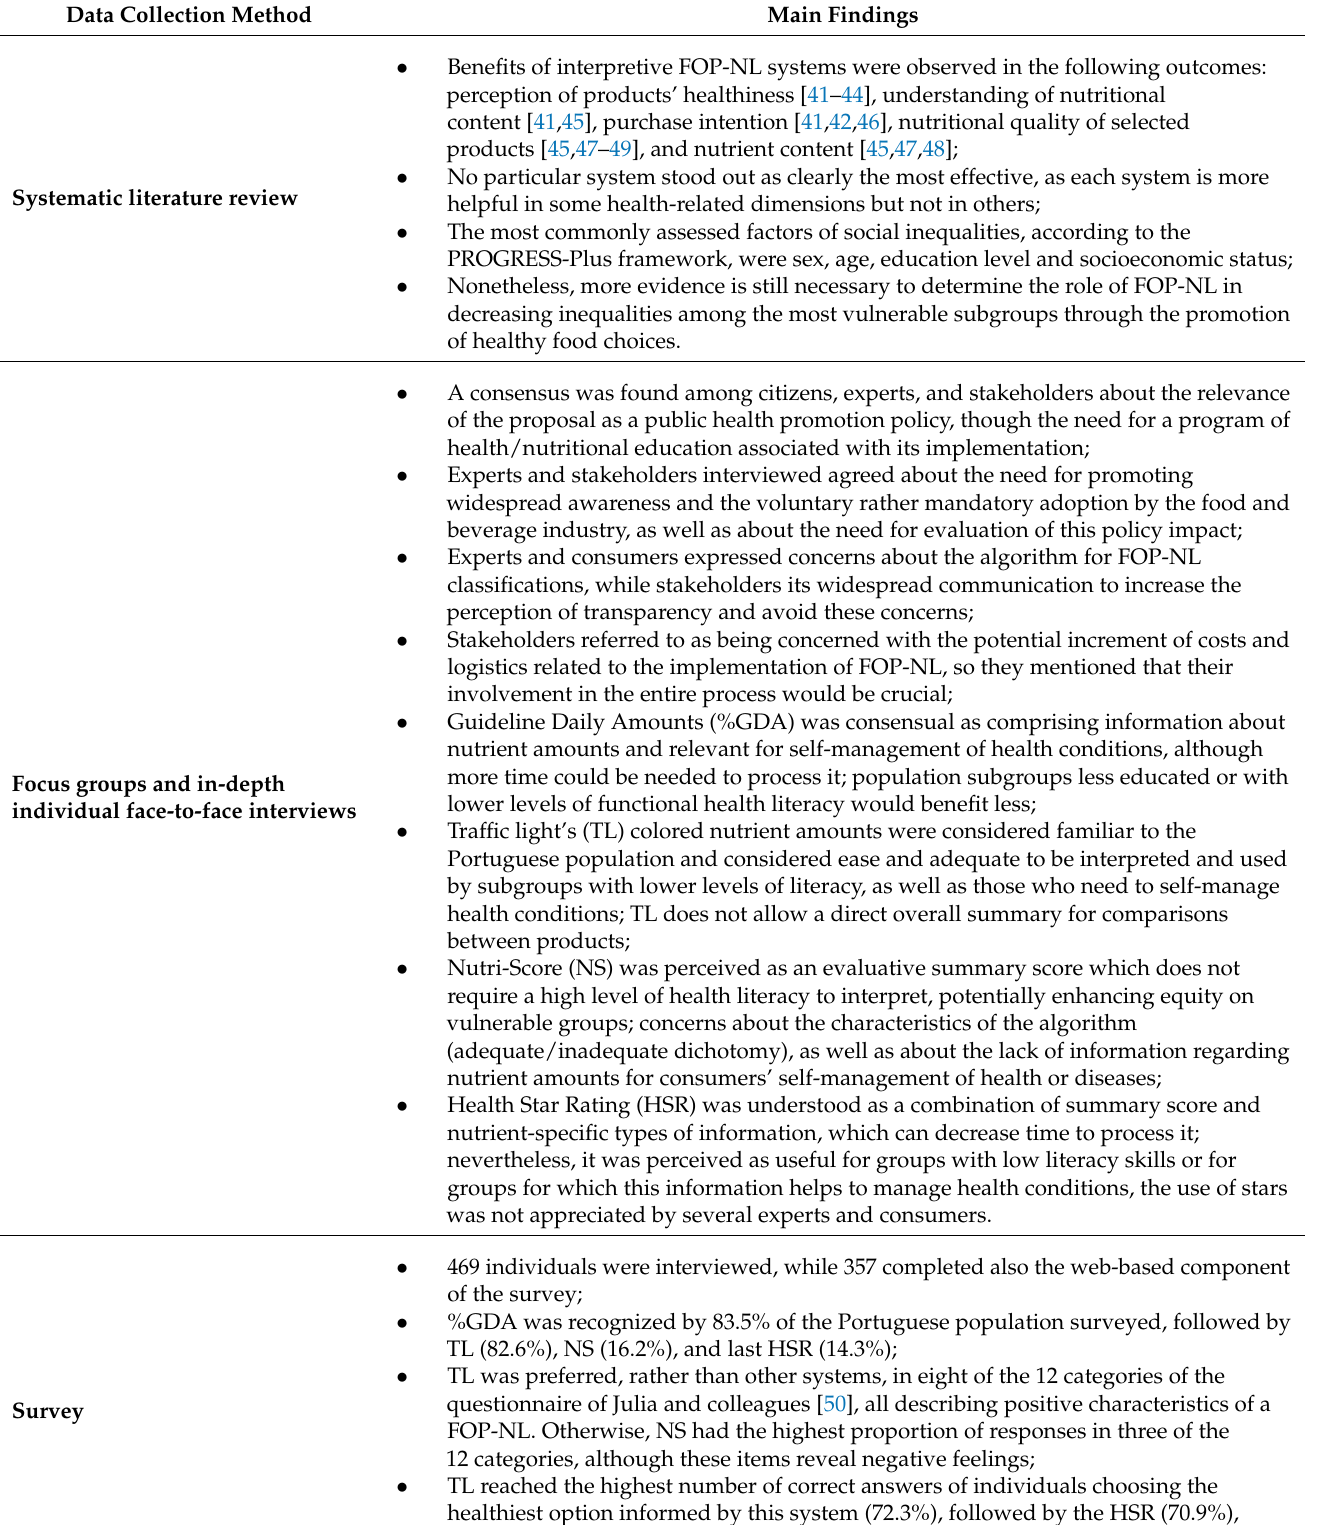
Table 2. Main findings on potential impacts of the proposal, gathered through a mixed-method